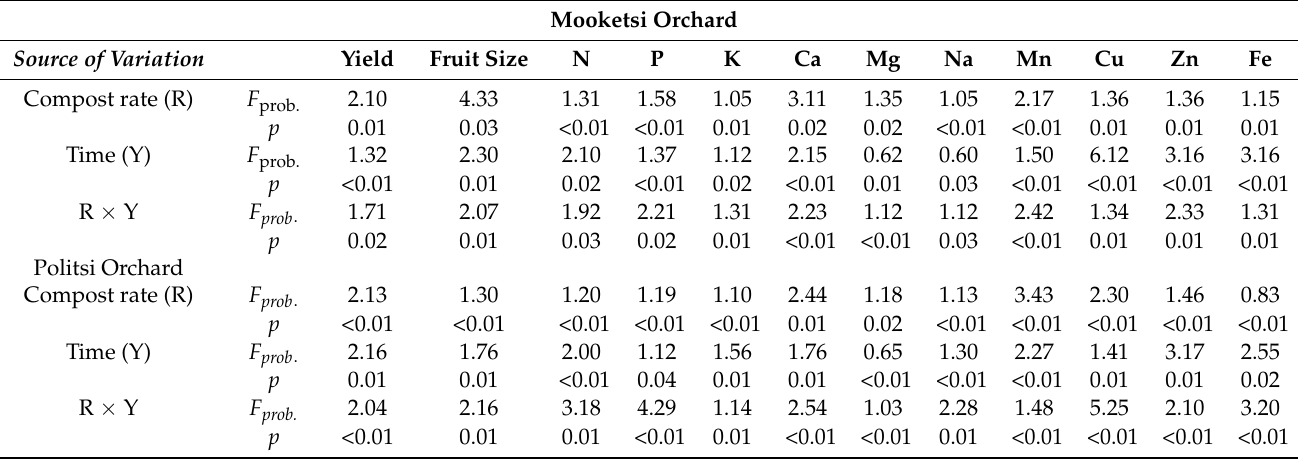
Table 2. ANOVA for yield, fruit size, and foliar nutrient element content following a 3-year application of the eucalyptus-wood-based compost at the Mooketsi and Politsi